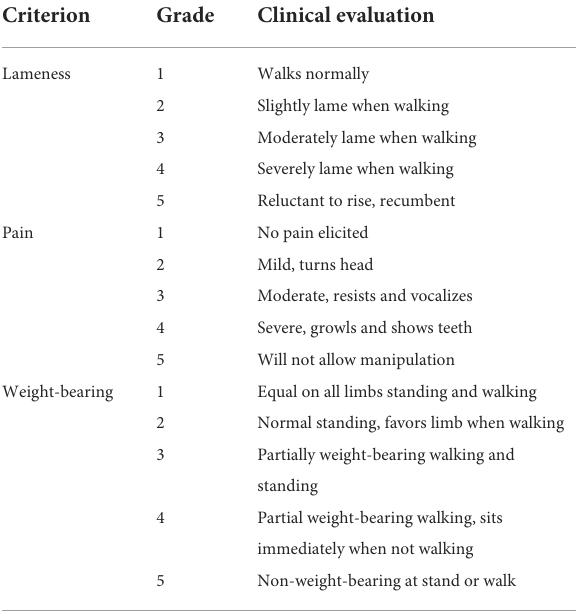
TABLE 1 Standardized veterinary assessment scoring system used to evaluate all dogs in the study, before and after a tibial plateau leveling osteotomy